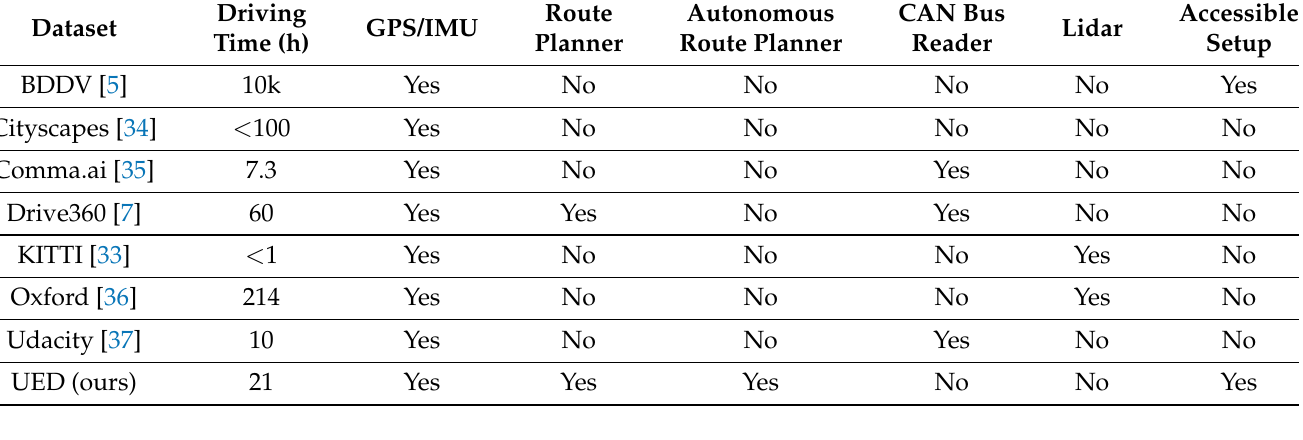
CAN Bus Accessible Lidar